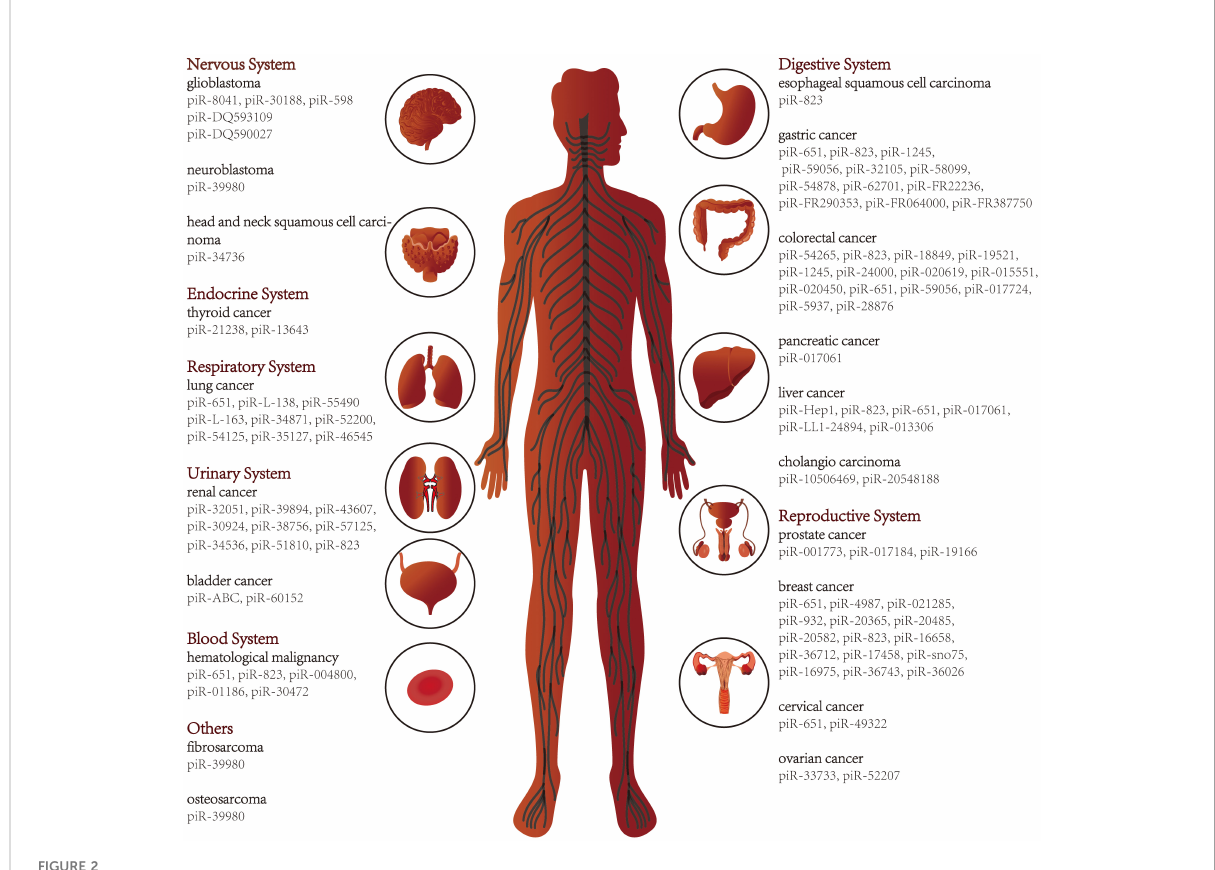
FIGURE 2 piRNAs in various types of